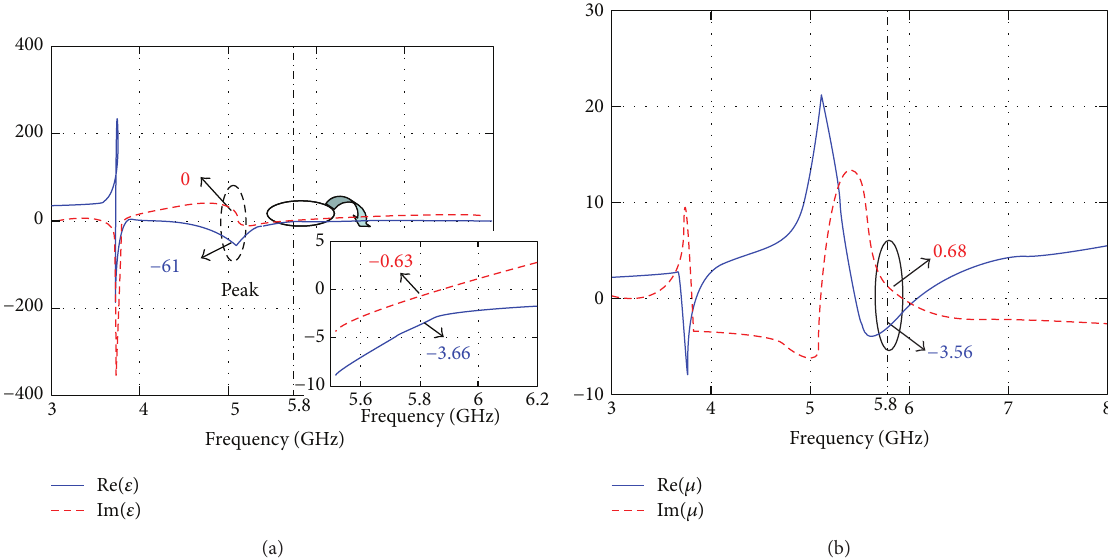
Figure 9: Effective permittivity (a) and permeability (b) of FL-LHM unit-cell under an incident wave of 45 ∘ extracted from 𝑆 parameters correspondent.